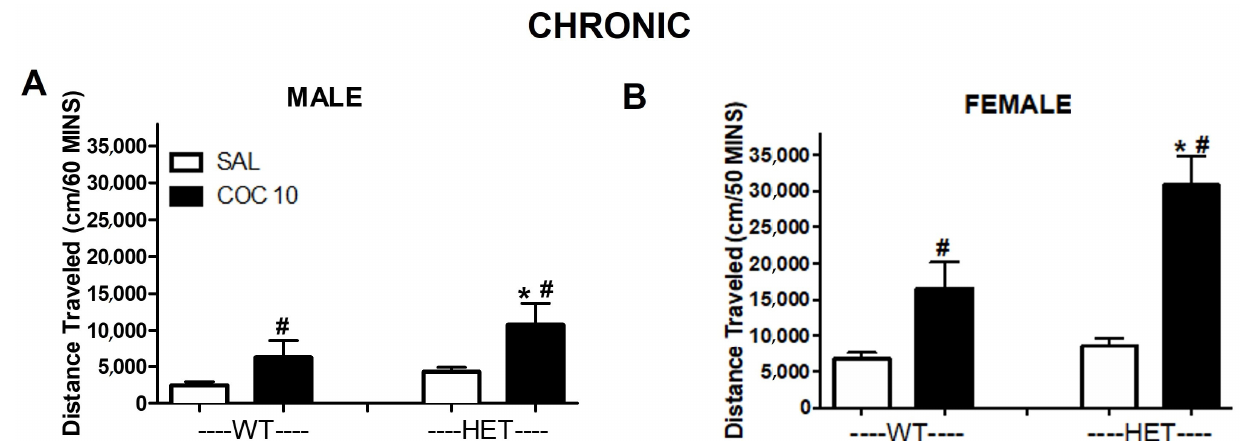
Figure 4. Effect of chronic cocaine (10 mg/kg) on cumulative distance traveled in DAT mutant rats. Cumulative time (30 min after acute treatment) is represented across conditions (SAL = saline, COC 10= 10 mg/kg cocaine) in males ( A ) and females ( B ). # p < 0.05 compared to SAL; * p < 0.05 compared to WT. Mean ± SEM. (males: WT N = 15, HET N = 36; females: WT N = 24, HET N = 24).